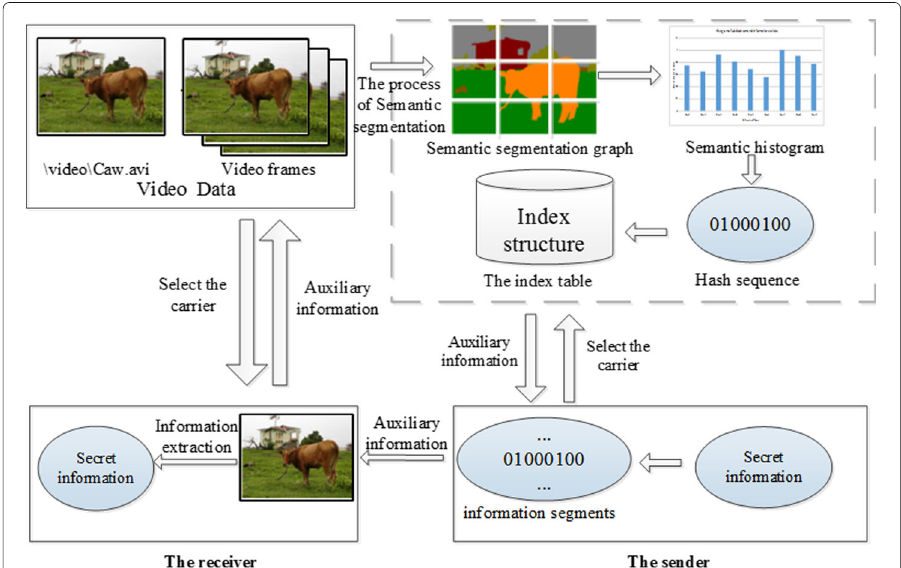
Fig. 4 Framework of coverless information hiding